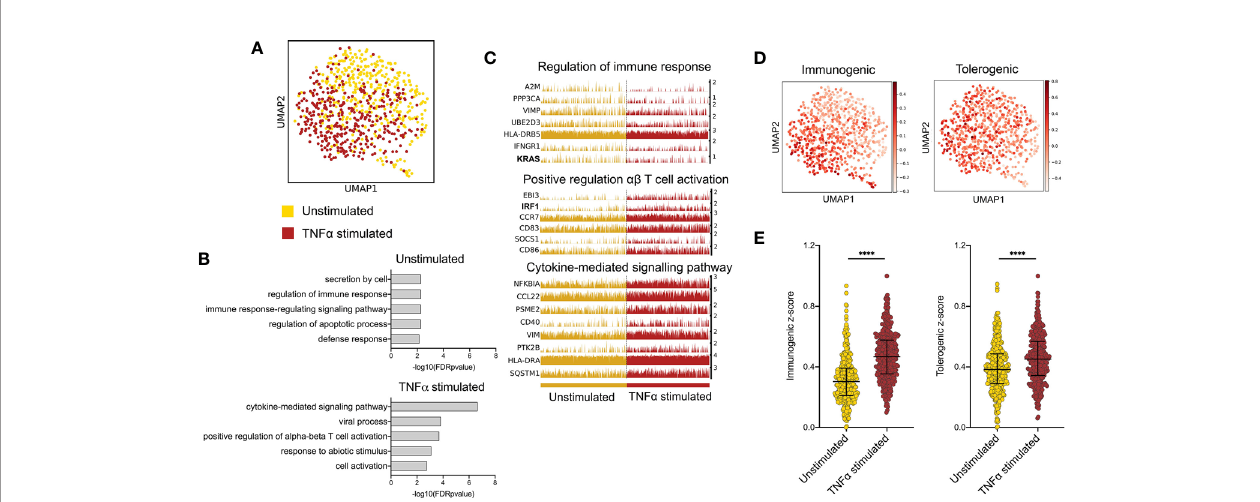
FIGURE 1 | TNF-alpha enhances immunogenic transcriptional programming in migratory LC. (A) UMAP dimensionality reduction analysis of scran-normalised single cell data from unstimulated (375) and TNF-alpha stimulated (362) migrated LCs originating from the same donor. (B) Gene ontology analysis (Toppgene) for the 61 upregulated DEGs in unstimulated LCs and 87 upregulated DEGs in TNF-alpha stimulated LCs (FDR corrected p=<0.05). (C) Trackplots displaying genes included in ontologies upregulated in unstimulated LC (regulation of immune response) and TNF-alpha stimulated LC (positive regulation of ab T cell activation and cytokine- mediated signalling pathway). (D) UMAP marker plots displaying immunogenic z-scores and tolerogenic signature z-scores in individual LC. Immunogenic z-scores were derived from the expression of genes identi fi ed to be upregulated in TNF-alpha stimulated LC (0hr-24hr DEGs) from bulk RNA-seq data (5). Tolerogenic signature z-scores were derived from the expression of genes associated with dendritic cell tolerogenic function (9). (E) Immunogenic and tolerogenic z-score values are displayed for unstimulated and TNF-alpha stimulated LC. Mann-Whitney test,